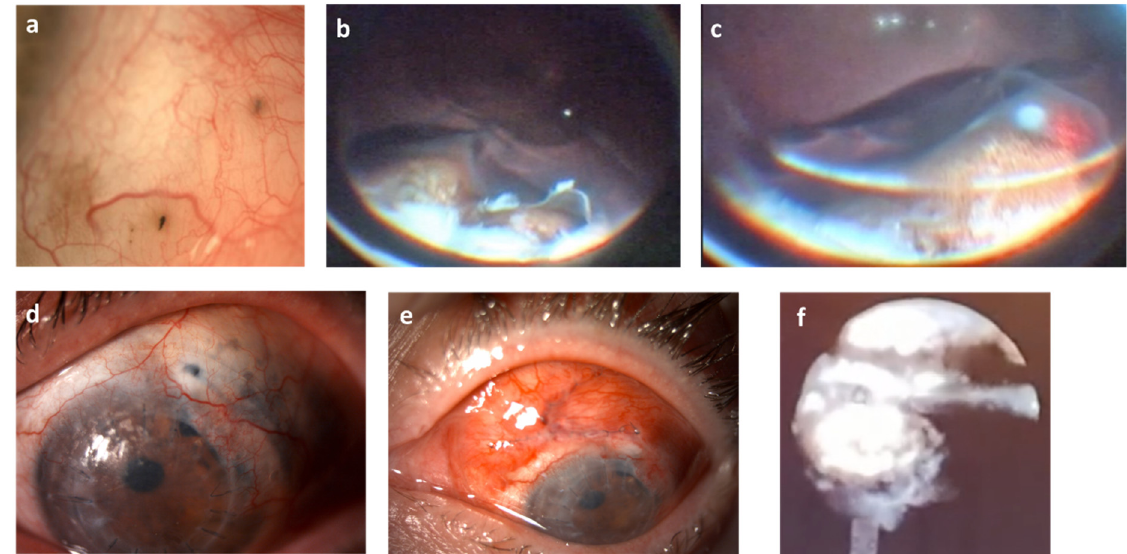
Figure 5. Examples of different techniques after surgery, showing ( a ) migration of macrophages from the pigment epithelium 2 years after treatment with ruthenium-106 plaque.; ( b , c ) extrascleral diodeopexy in peripheral rupture after exoresection in tumor previously treated with brachytherapy; ( d ) punctate scleromalacia; ( e ) treatment with tenon patch and conjunctival zetaplasty; ( f ) endoresection image with ocular endoscope.